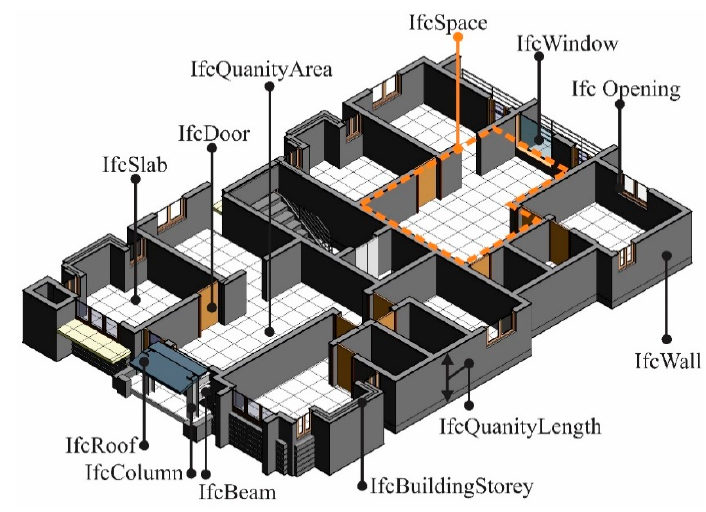
Figure 10. Main Ifc objects referenced in the example.